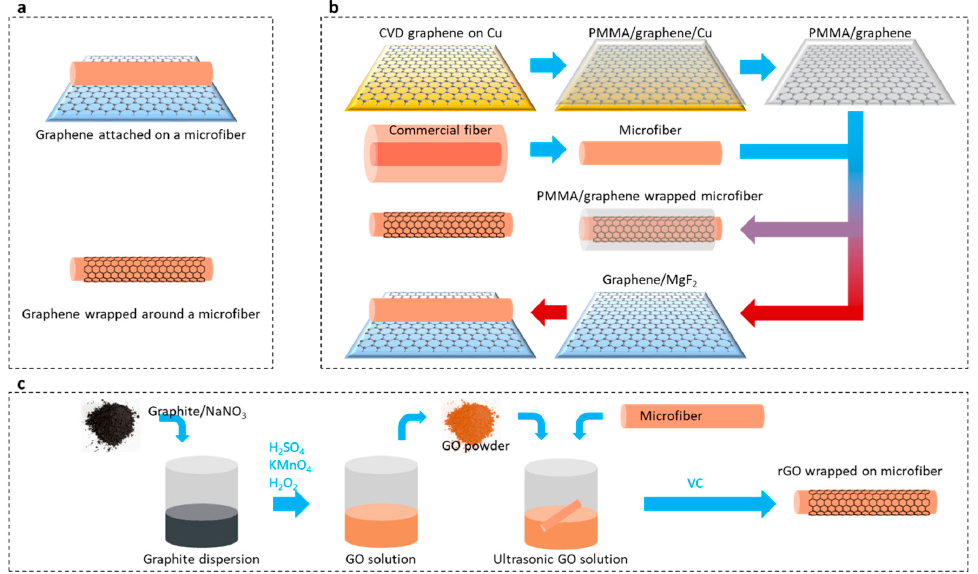
Figure 6. Fabrications. ( a ) Two types graphene-based microfiber structure. ( b ) Fabrication flow of both the graphene-attached microfibers and the graphene-wrapped microfibers, based on CVD graphene. ( c ) Fabrication flow based on GO reduction.